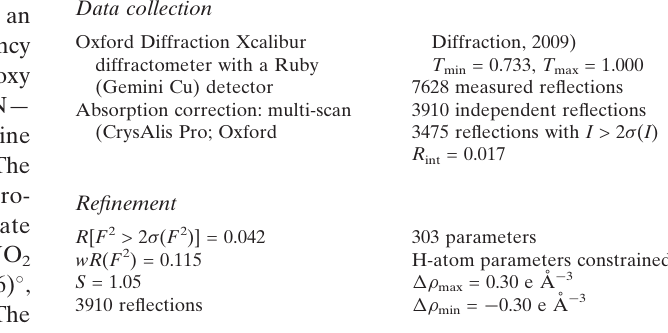
Oxford Diffraction Xcalibur diffractometer with a Ruby